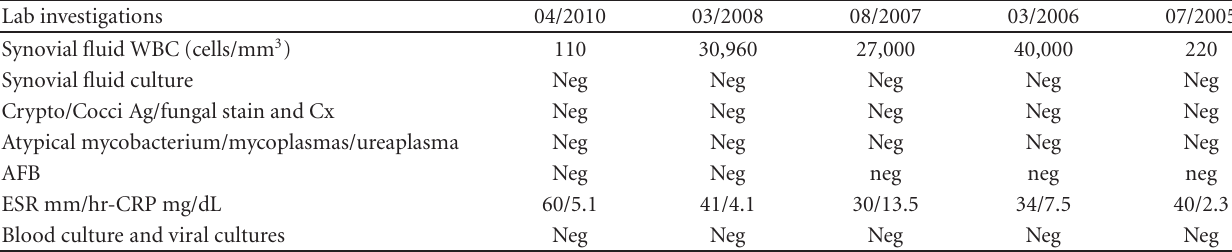
Table 1: Laboratory evaluation of the synovial fluid and blood performed in a 12-year-old boy with X-linked agammaglobulinemia and recurrent knee e ff ussions over a period of 5